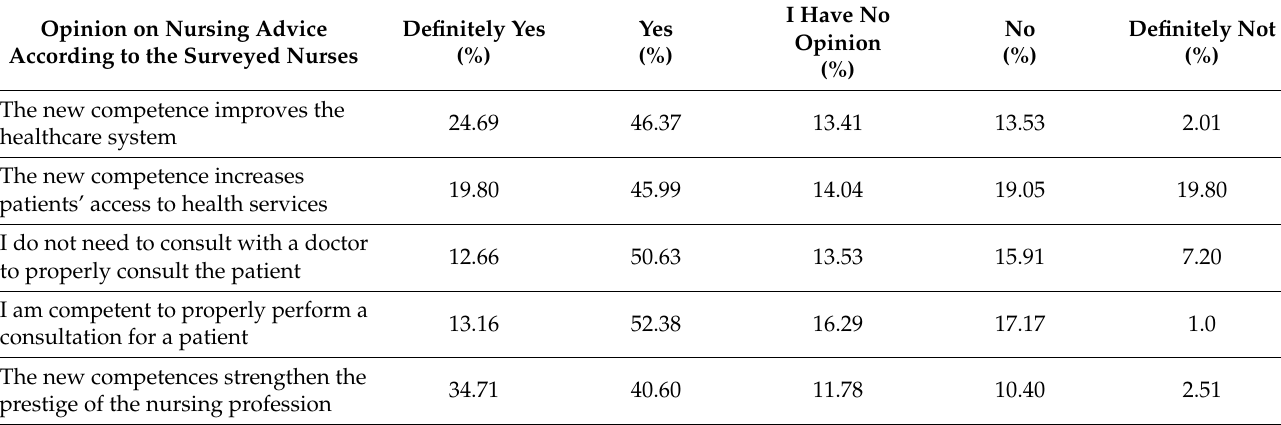
Figure 1. Nurses’ opinion on the scope of nursing advice. Table 2. Nurses’ opinion on nursing advice and self-preparation to take on new